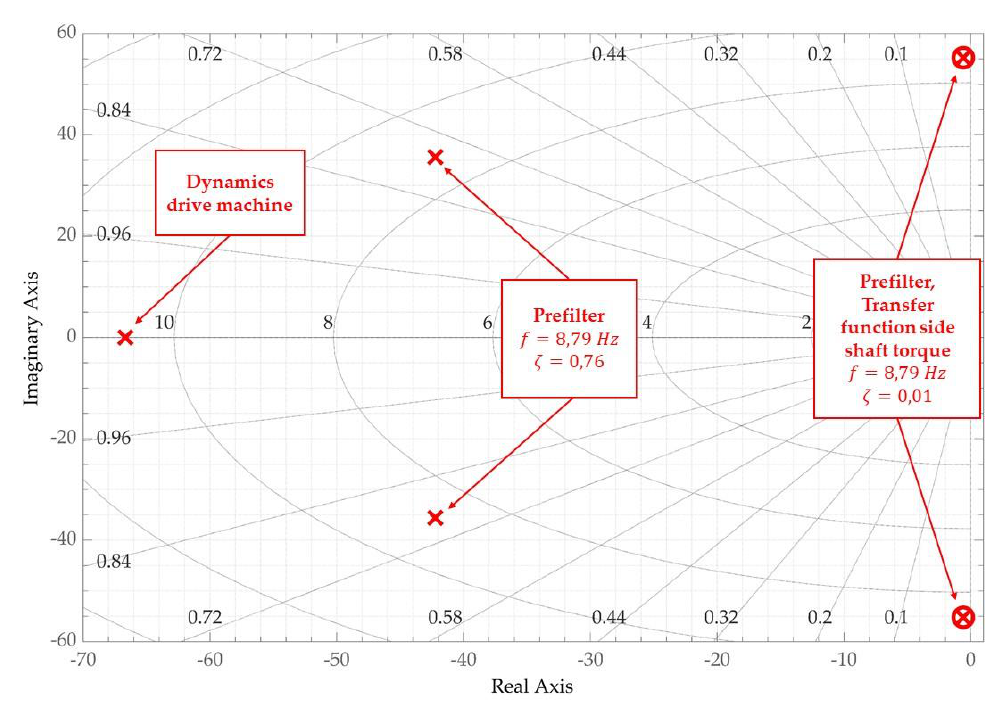
Figure 10. Pole-zero map for the prefilter and the simplified real system. Table 2. Poles of the Transfer function of the prefilter and the simplified real system.